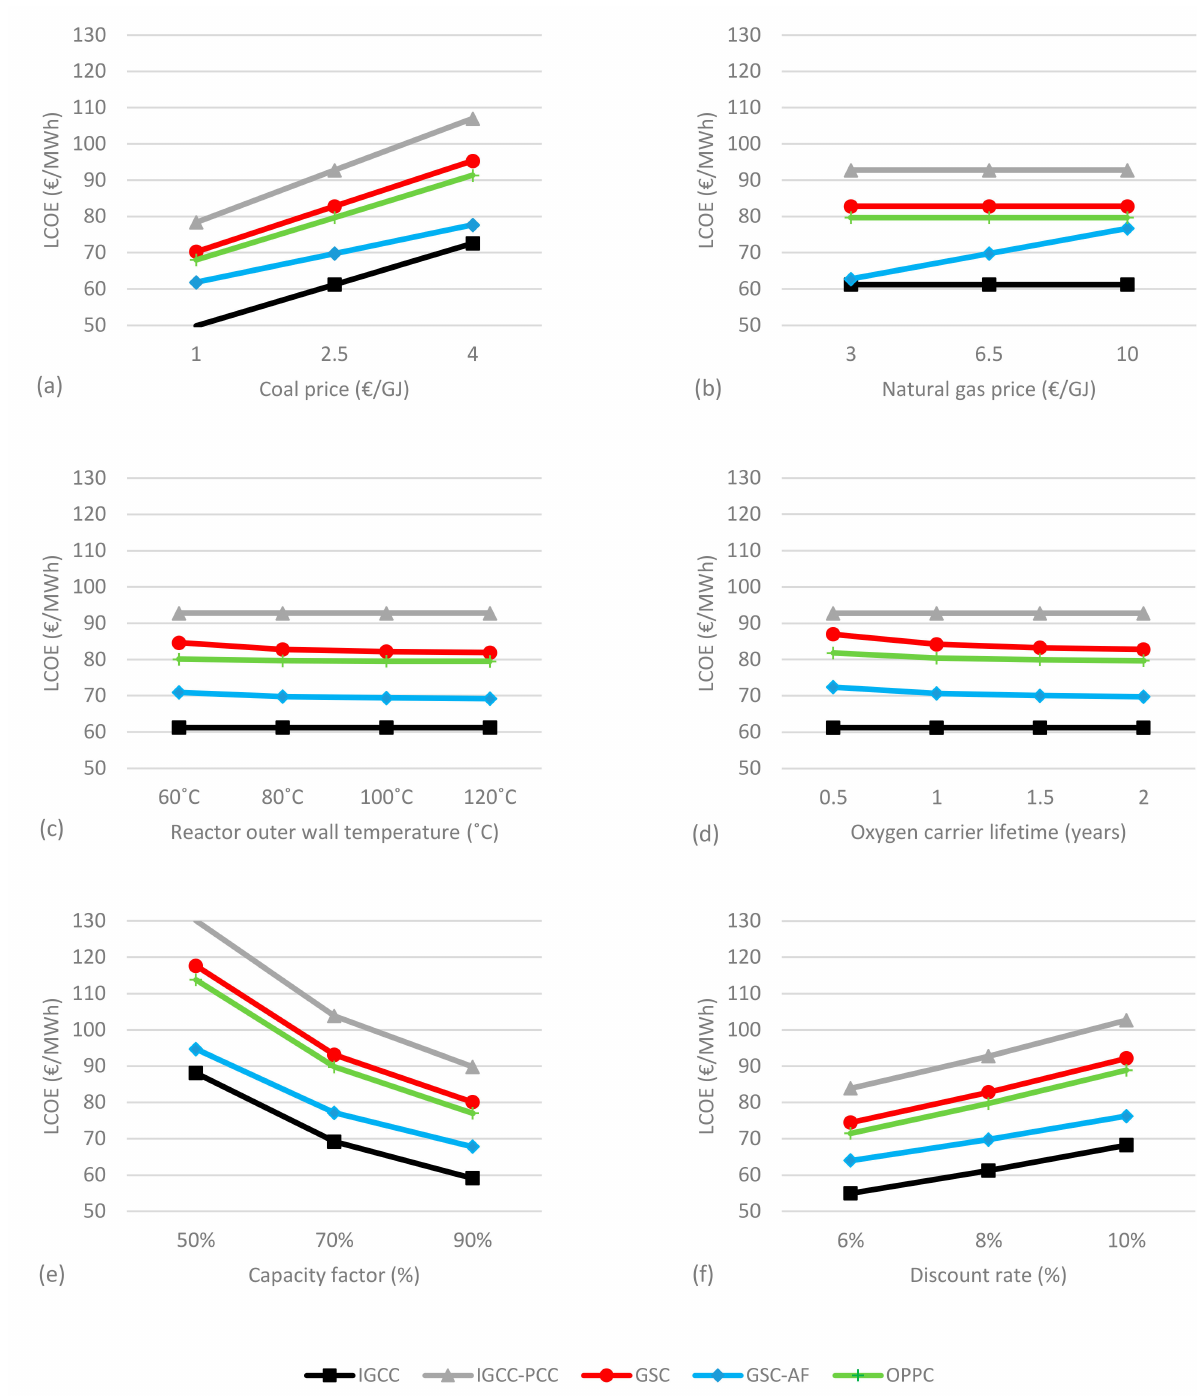
Figure 8. Sensitivity analysis to coal ( a ) and natural gas ( b ) prices, reactor outer wall temperature ( c ), oxygen carrier lifetime ( d ), capacity factor ( e ), and discount rate ( f